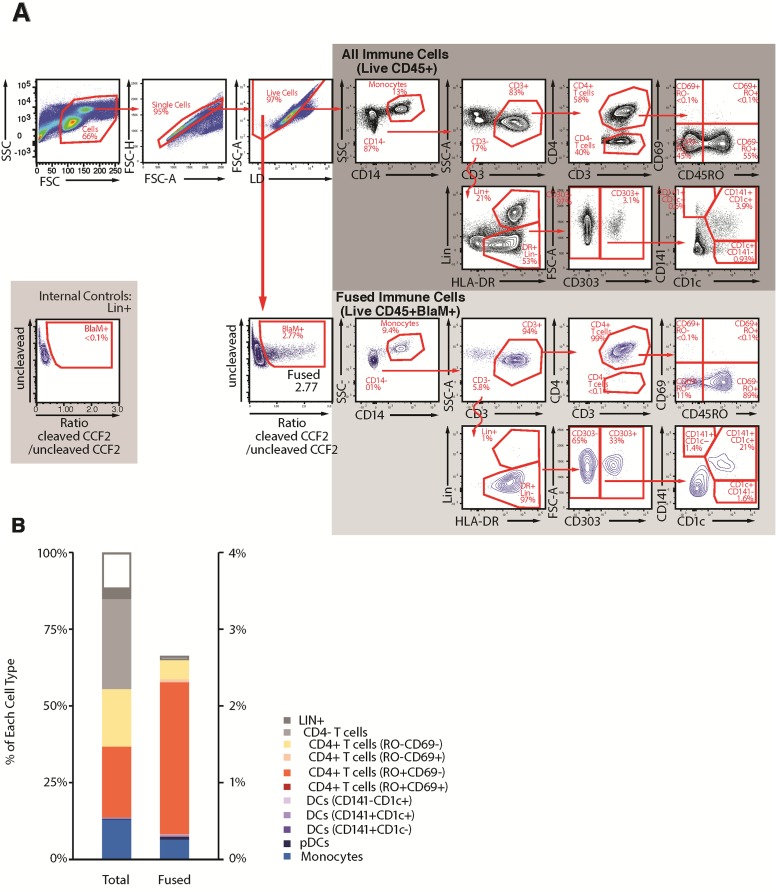
Fusion assay combined with immunostaining allows measurement of the percentage and phenotypes of immune cells that support HIV-1 fusion in cells from peripheral blood.(A) Gating strategy: The first 4 multicolor FACS plots allow the identification of the “Live cells”. From this gate, the “BlaM+ cells” can be defined and represent the immune cells that supported ZM247v2 viral fusion. The FACS plot on the gray background show the gating strategy to identify 11 cellular subsets among the “all immune cells” (dark gray) and among “fused immune cells” (light gray). Note that LIN+ can be used as internal control for gating the fused (bottom left inset). (B) For a blood sample from a single participant, paired bar graphs show the distribution of immune cell phenotypes (left) and prevalence of prevalence of fusion susceptibility by phenotype (right). In this sample our immunophenotyping panel recognized the phenotype of more than 85% of the immune cells present in blood, and overall prevalence of fusion susceptibility was 2.6%.